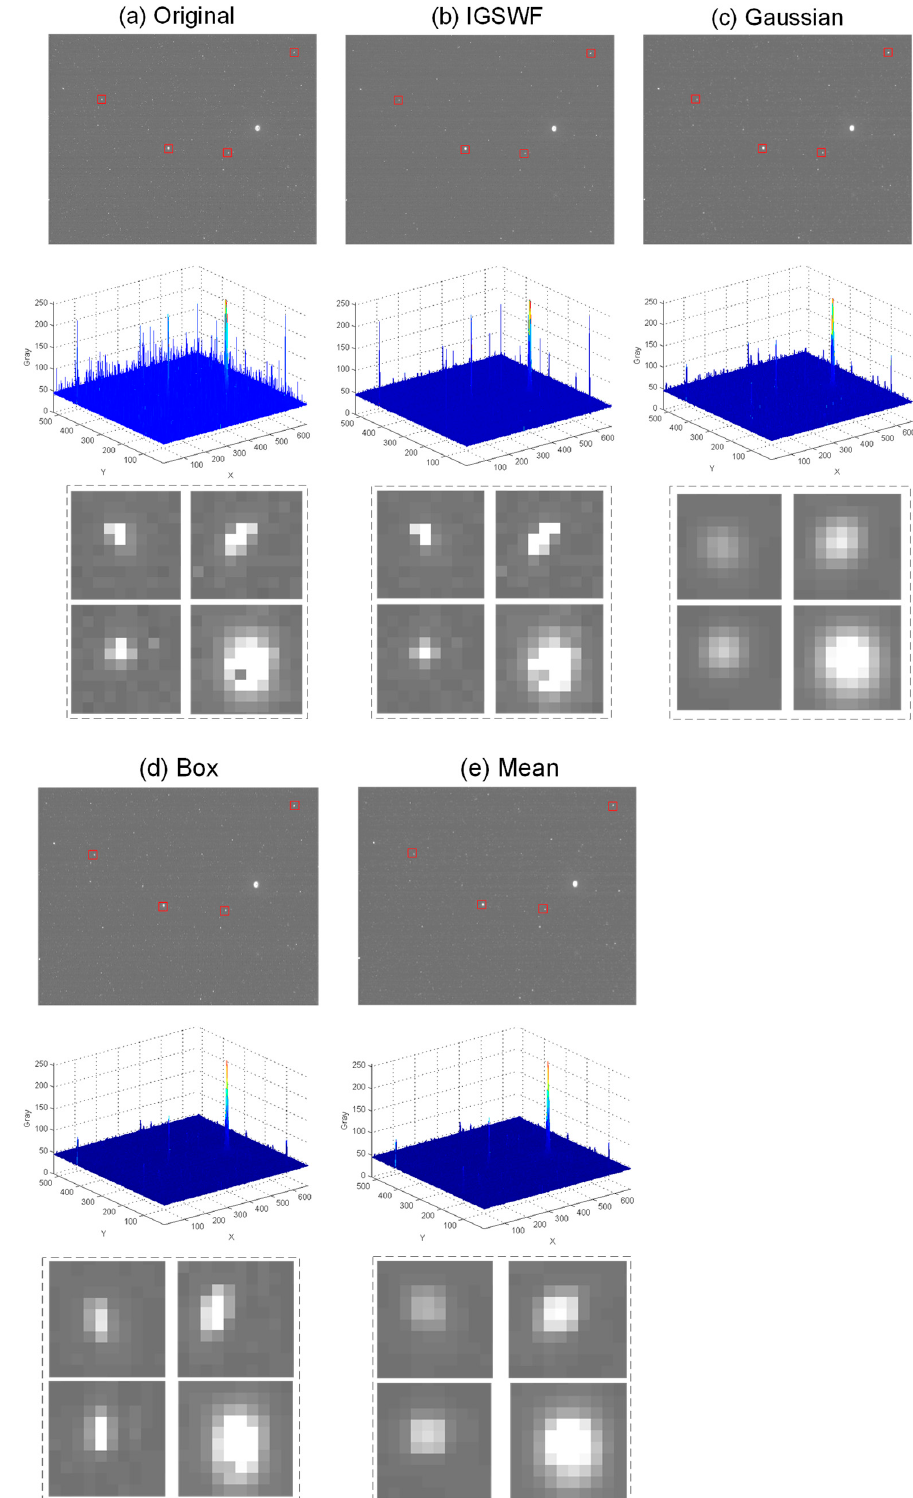
Figure 13. Comparison of the IGSWF algorithm with Gaussian filtering, box filtering, and mean filtering: ( a ) before denoising; ( b – e ) after denoising by the IGSWF algorithm, Gaussian filtering, box filtering, and mean filtering, respectively. The first lines are star images, the second lines are the three-dimensional distribution of the grayscale in the star image, and the third lines are the local star